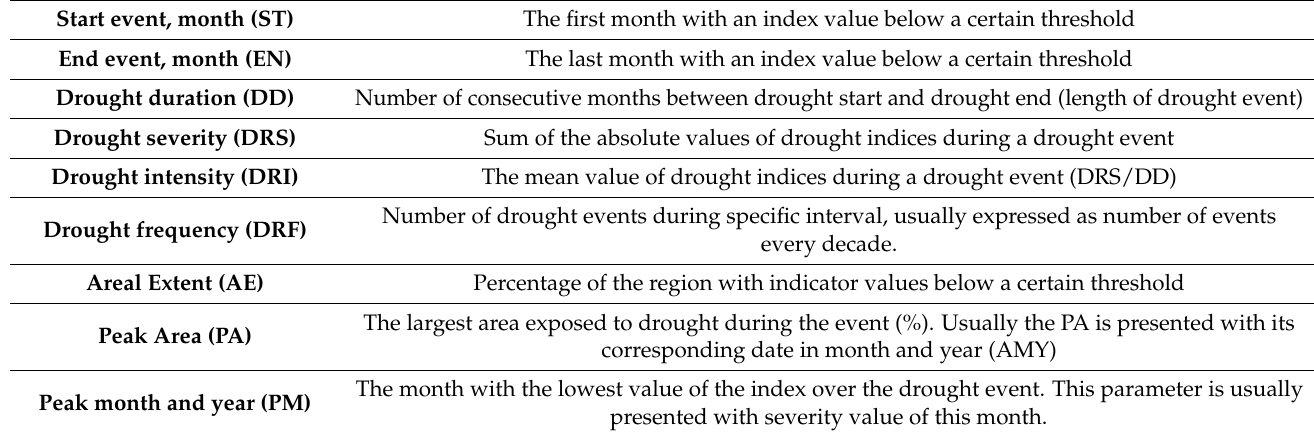
Table 1. Parameters used for a drought event evaluation as listed in the